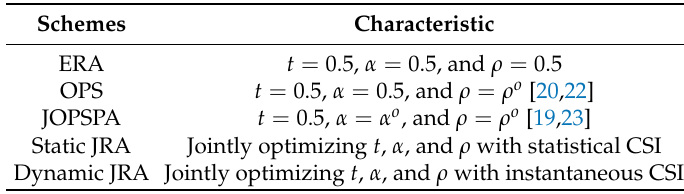
Table 1. Characteristics of different resource allocation schemes. ERA—equal resource allocation; OPS—optimal power splitting; JOPSPA—joint optimal power splitting and power allocation; JRA—joint resource allocation; CSI—channel state